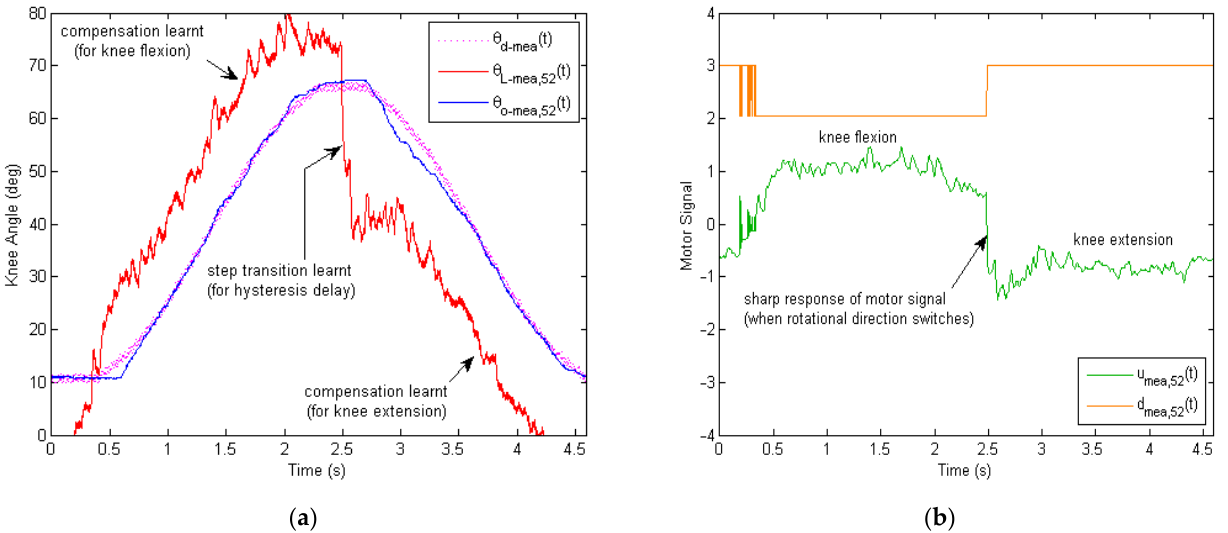
Figure 18. Analysis of the measured learning compensation for the inner loop. Sharp-step transitions weregenerated through learning over repetitions, which compensate for the hysteresis delay caused by the Bowden cable friction and gear-reducer backlash. ( a ) Comparison of the learnt reference input knee angle 𝜃 𝐿−𝑚𝑒𝑎 (𝑡) for the inner PD control loop and the desired knee angle 𝜃 𝑑−𝑚𝑒𝑎 (𝑡) for the outer loop, at iteration #52. ( b ) Time history of the motor control signal 𝑢 𝑚𝑒𝑎 (𝑡) and motor direction signal 𝑑 𝑚𝑒𝑎 (𝑡) , at iteration #52.